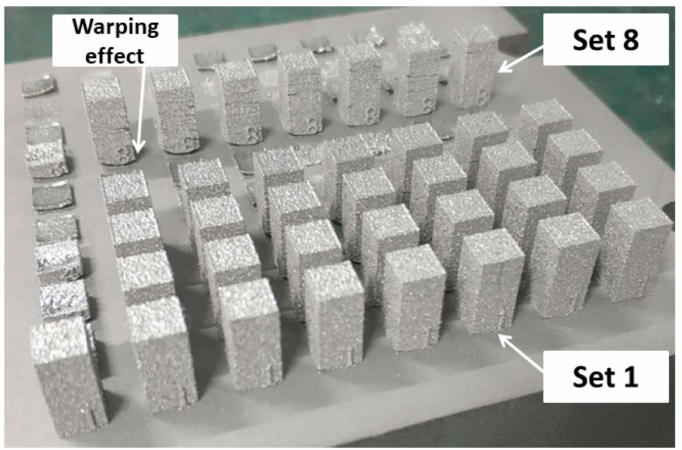
Figure 3. Image of samples, printed from about 58 wt.% Ni + 42 wt.% Ti powder mixture, processed by different processing